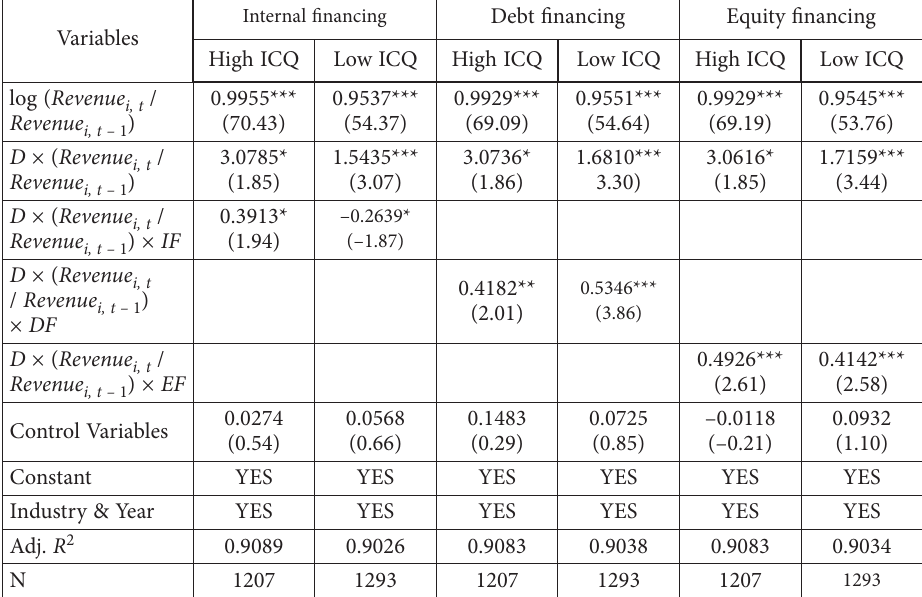
Table 3. Regression results of the moderation effect of internal control